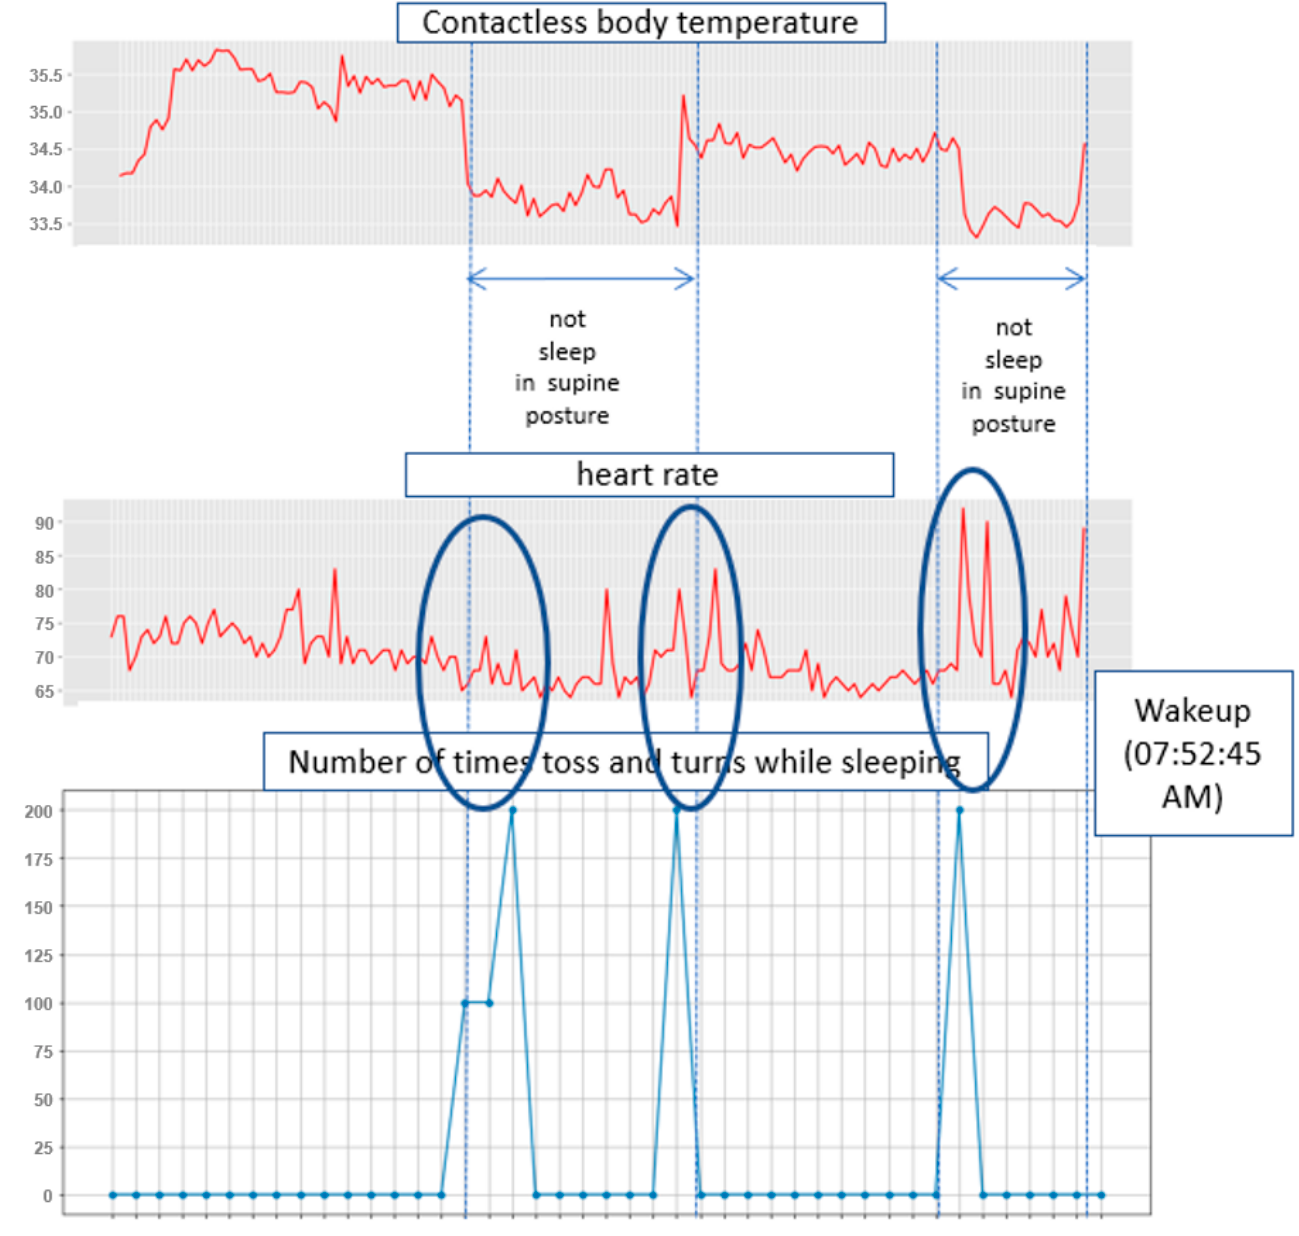
Figure 14. Changes in heart rate according to the frequency of tossing and turning.